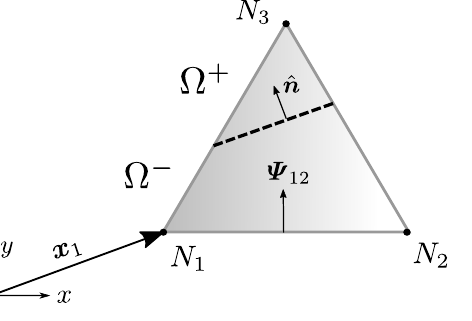
Figure 7. Two-dimensional CST element having a strong discontinuity with a vector ˆ n and a partition 2-1, node 3 located on Ω + . The vector Ψ , in this case, corresponds to the normal to the surface defined by nodes N 2 , N 3 , N 4